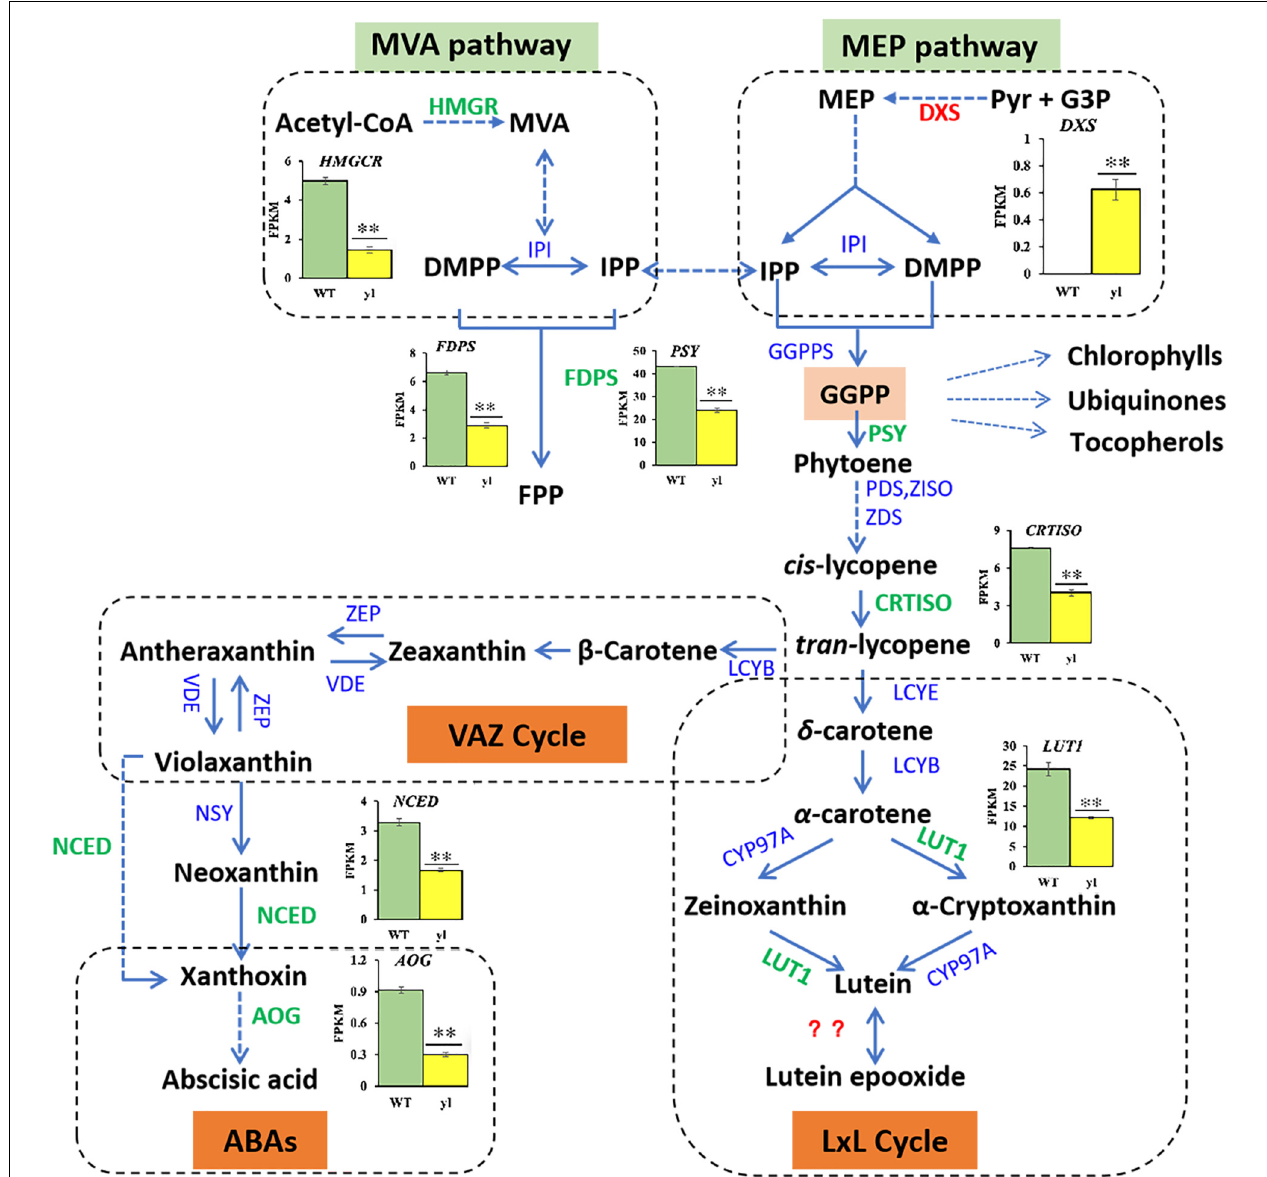
FIGURE 7 | Differentially expressed genes (DEGs) related to carotenoid biosynthesis. FDPS, 1-deoxy- D -xylulose-5-phosphate synthase; NCED, 9- cis -epoxycarotenoid dioxygenase; AOG, abscisate